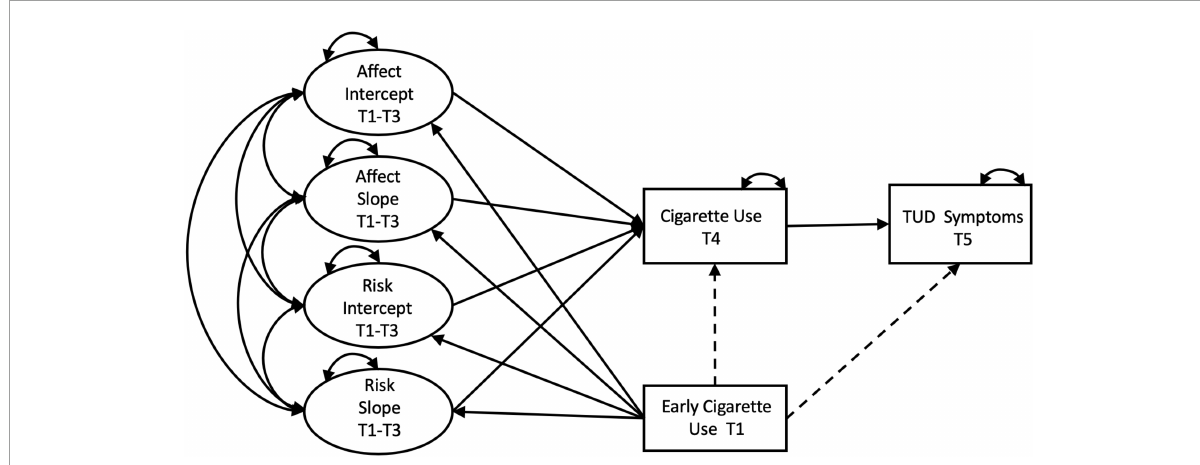
FIGURE1 Hypothesized Model. Single-headed straight lines represent regression pathways, double-headed curved lines represent covariances. Dashed pathways signify effects that are hypothesized to be non-significant. Manifest variables corresponding to the latent intercepts and slopes were omitted from the diagram for clarity. Effects of covariates was assessed on intercepts and slopes of affect and risk, and on cigarette use at T4. These pathways have also been omitted for